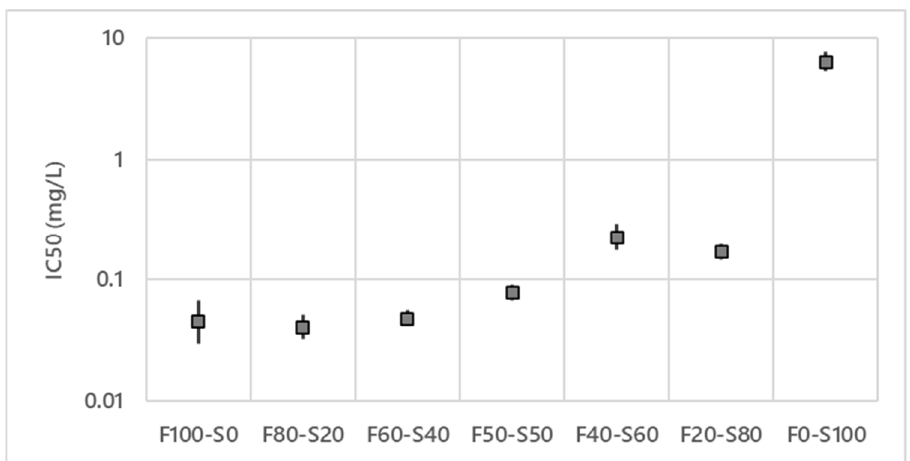
Figure 2. Effect of the lipopeptide ratios ( w / w ) on the IC 50 of fengycin/surfactin mixtures on V. inaequalis S755 strain. IC 50 in logarithmic scale.